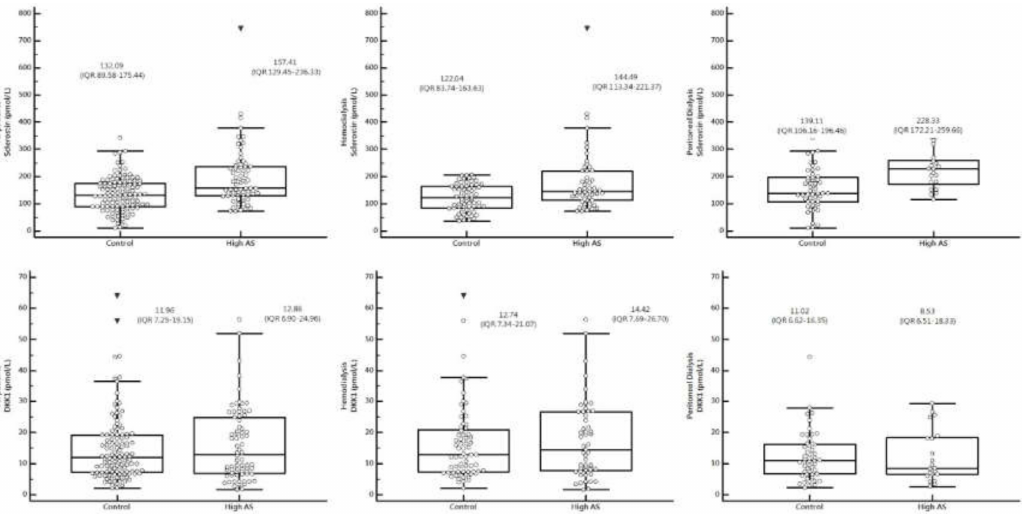
Figure 2. Values of sclerostin and DKK1 shown as box and whisker plots of all patients ( left panel ), HD ( middle panel ), and PD ( right panel ).